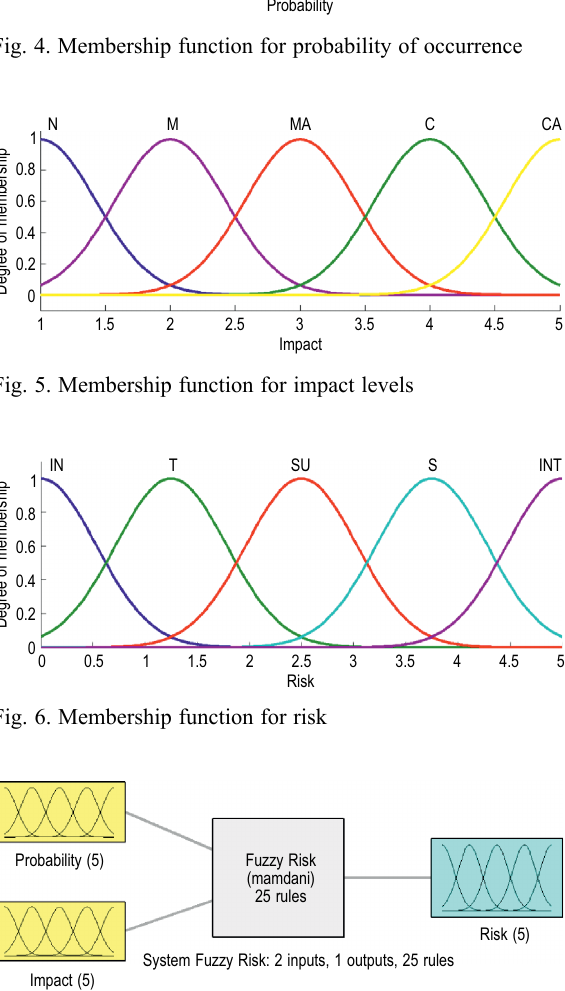
Fig. 3. Structure of FIS